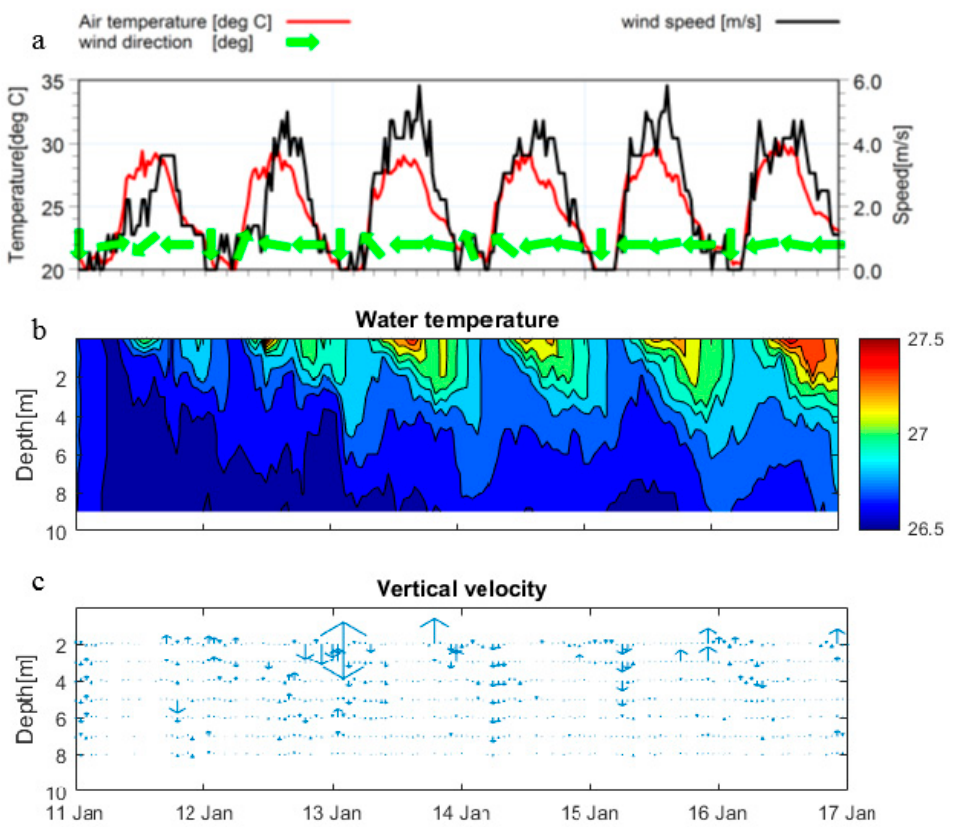
Figure 4. Time series of ( a ) air temperature and wind conditions; ( b ) the vertical profile of water temperature; ( c ) vector plot vertical velocity for the top 9 m in summer from 11 Jan 2014 to 17 Jan 2014 for Tingalpa Reservoir.